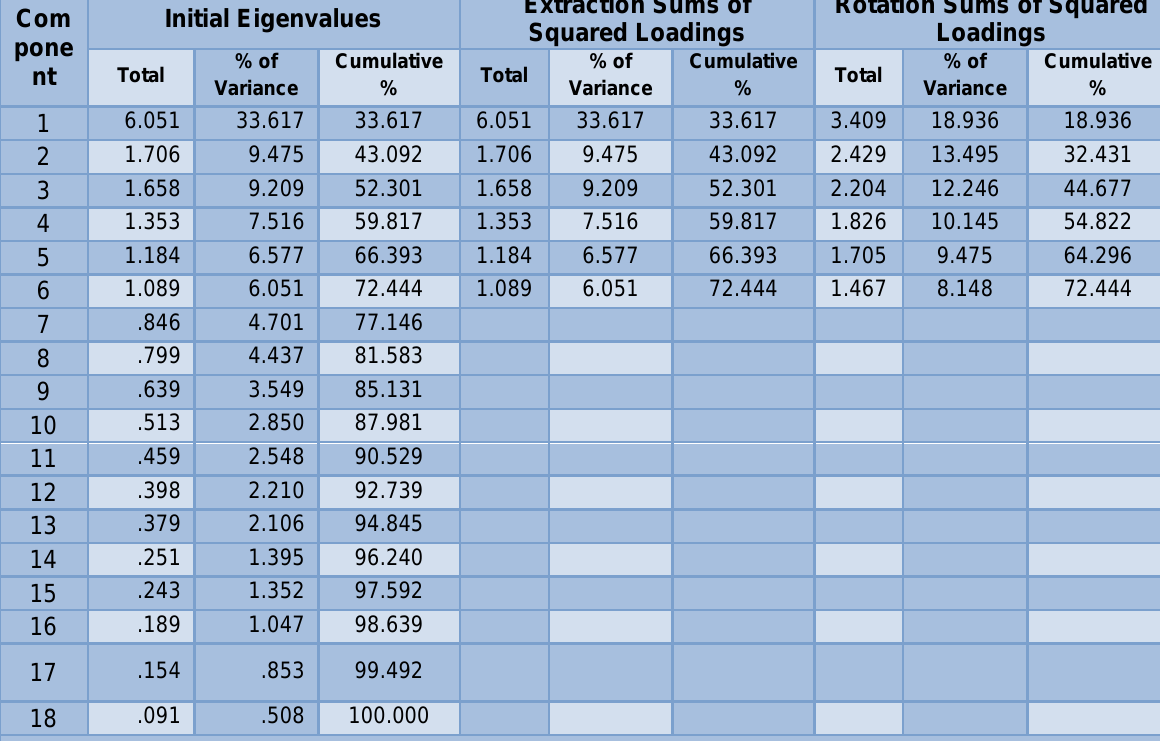
Table 3: Total Variance